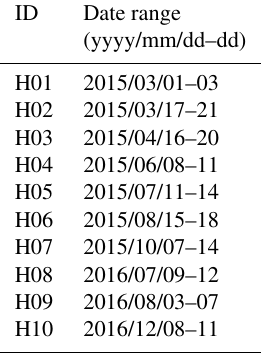
Table 1. The date range for HILDCAA intervals identified during years 2015–2016. ID Date